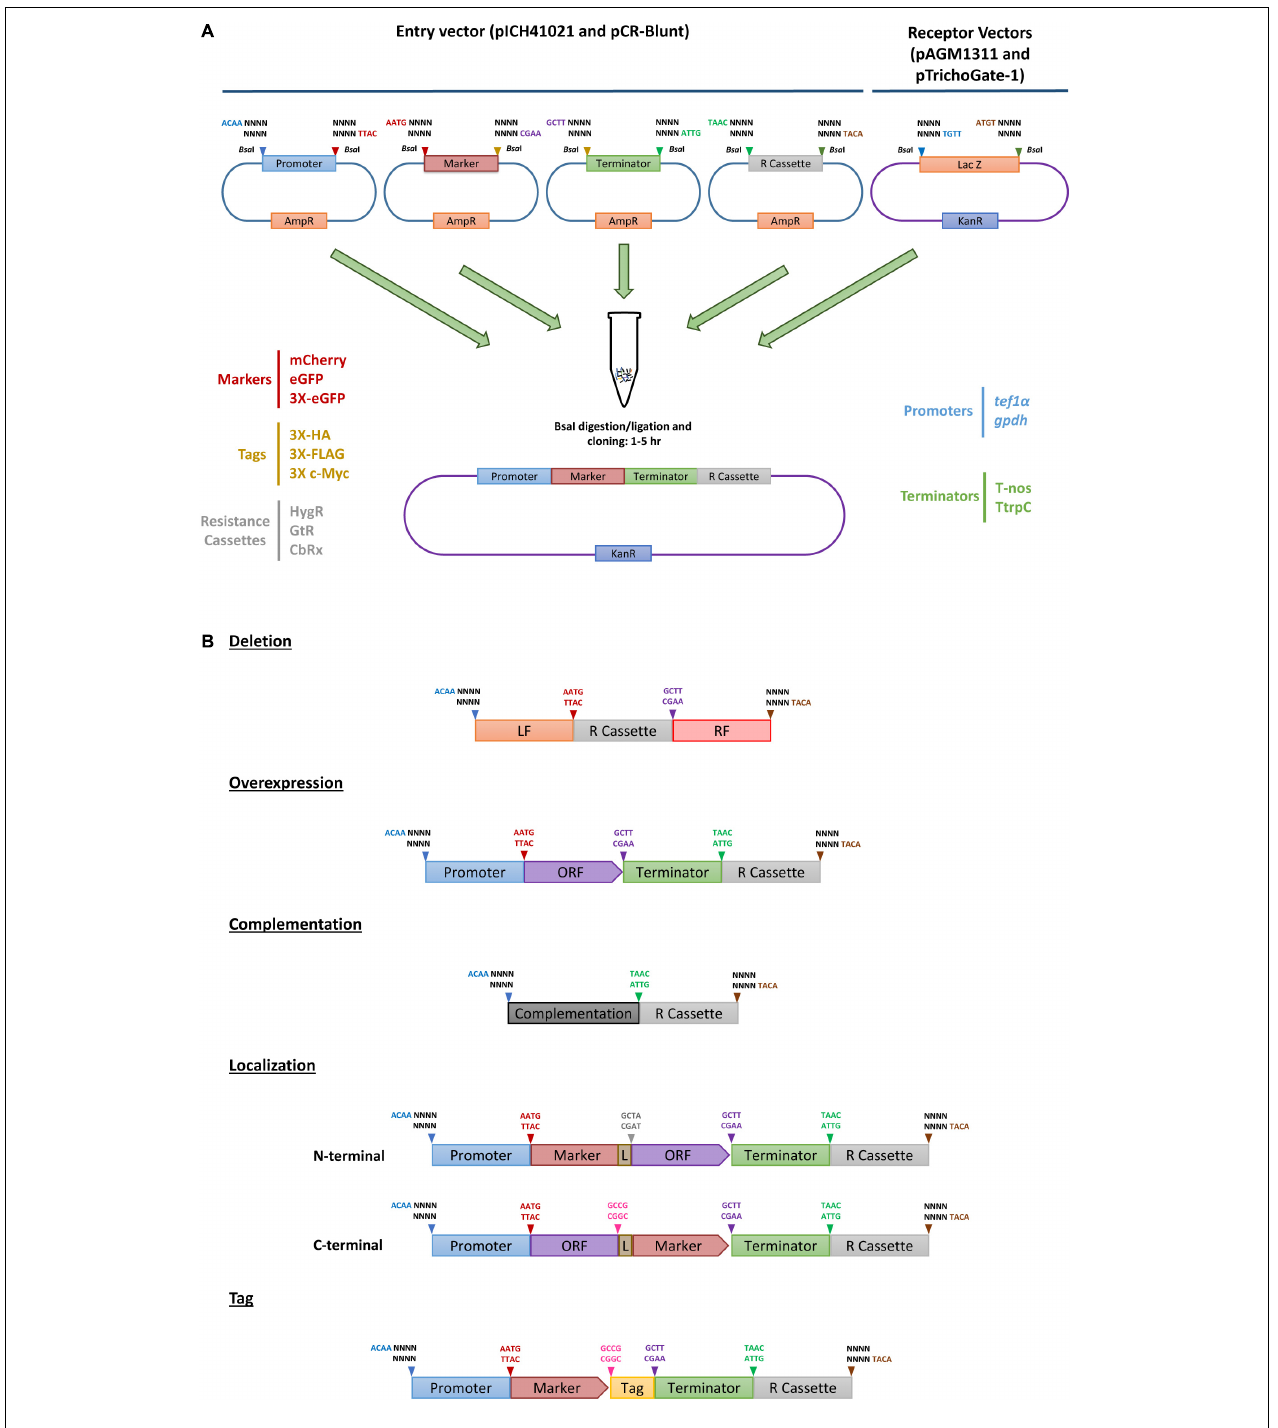
FIGURE 1 | TrichoGate cloning system. Schematic representation of the TrichoGate cloning strategy to accomplish genomic modification in T. virens . (A) Implementation of TrichoGate cloning system using type II restriction enzyme ( Bsa I), target DNA sequences containing Bsa I sites in their flanking regions with unique four bases overhangs must be subcloned in linearized entry vectors (pICH41021 or pCR-Blunt) carrying the ampicillin (AmpR) or kanamycin resistance (KanR) gene for selection in E. coli , respectively. TrichoGate vectors were constructed using up to five entry vectors (pICH41021 or pCR-Blunt) and/or PCR products containing synthetic DNA molecules of interest (e.g., promoters, markers, ORFs, terminators, tags and resistance cassettes) and one of the receptor vectors (pAGM1311 or pTrichoGate-1) that carry the KanR gene for selection in E. coli . Bsa I restriction-ligation was carried out in one single microcentrifuge tube containing target DNA molecules for up to 5 h. (B) Examples of hypothetically generated vectors using Bsa I restriction/ligation reaction for functional gene analysis in T. virens (e.g., gene deletion, gene complementation, overexpression, localization and immunoprecipitation).